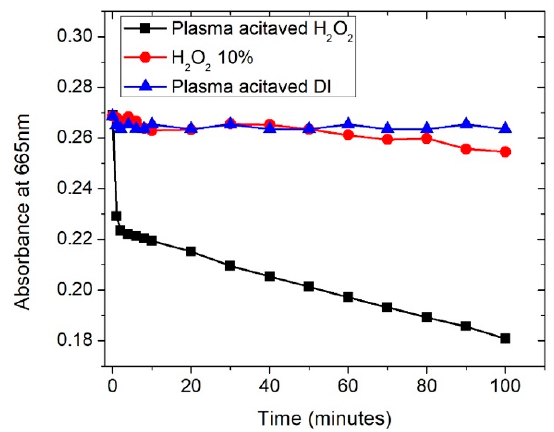
Figure 3. Time evolution of absorption peak at 665 nm of methylene blue after being added to plasma activated 10% H 2 O 2 , 10% H 2 O 2 , and plasma activated deionized water solutions.